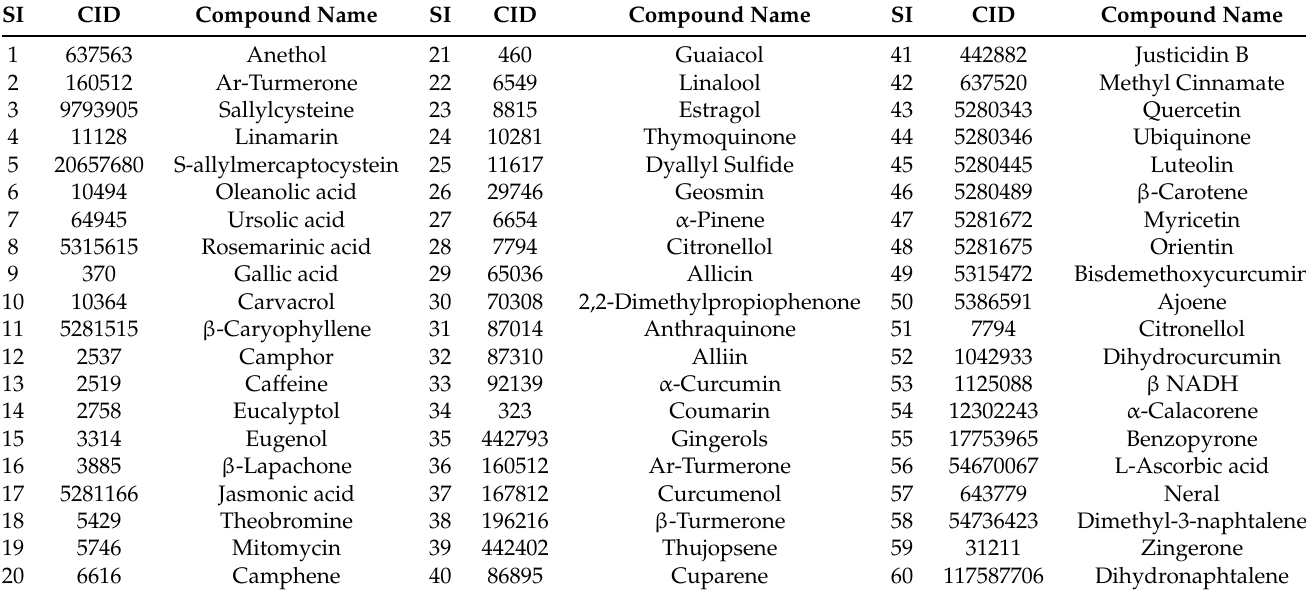
Table 1. Screening of phytobioactives against NQO1 protein.